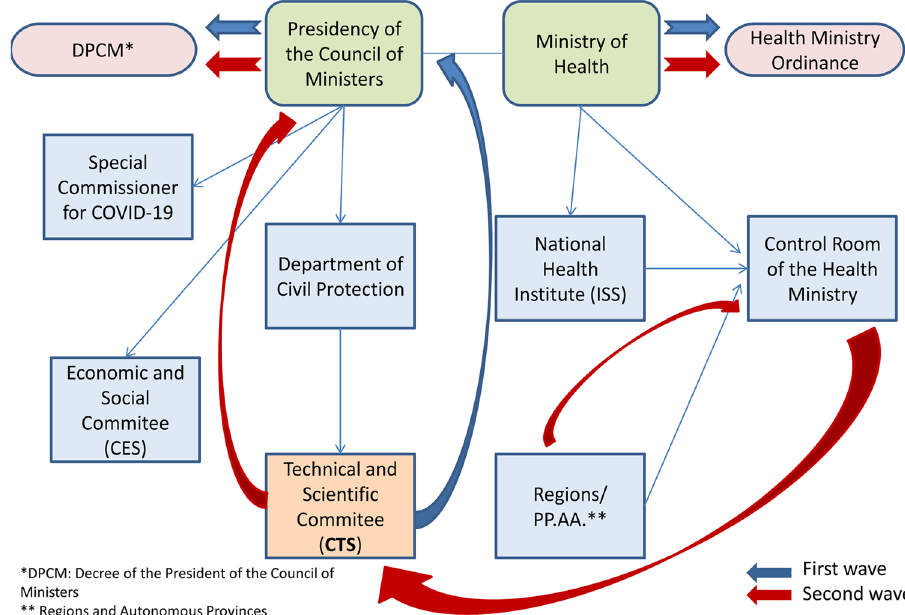
Fig. 3 Key players in the management of the Covid-19 crisis in Italy in the fi rst and second wave in 2020. Diagram by